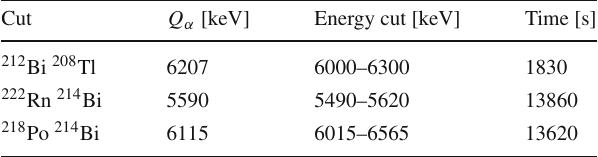
Table 1 Energy and time selections used for CUPID-Mo delayed coin- cidence cuts